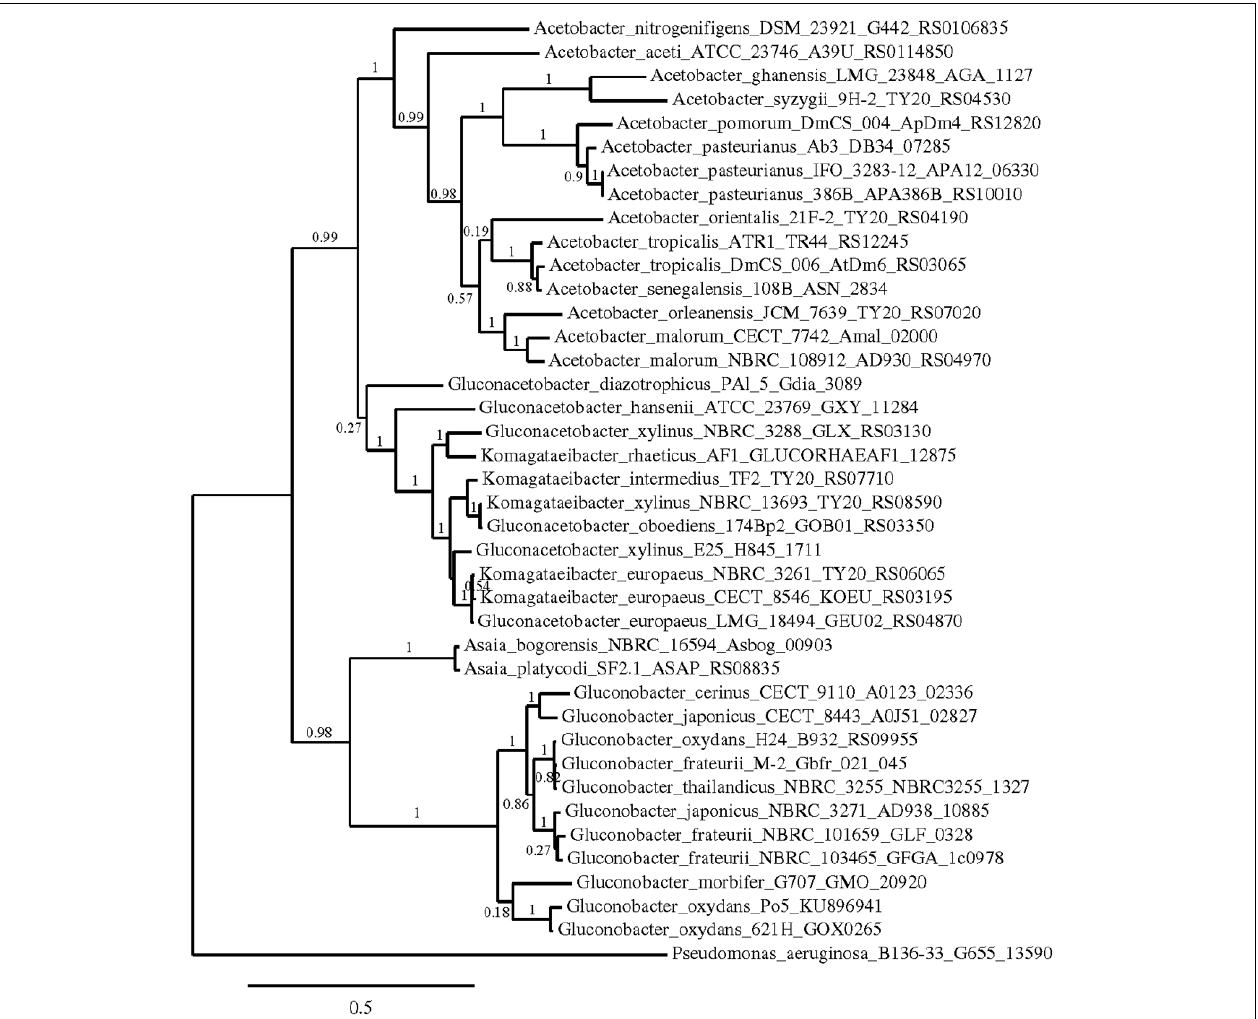
FIGURE 5 | Phylogenetic relationship of gcd gene in different species of acetic acid bacteria. The entries of different genotypes include the accession numbers of the GeneBank database sequence. The gcd sequence of Pseudomonas aeruginosa B136-33 was used as outgroup. The numbers indicate the branch support